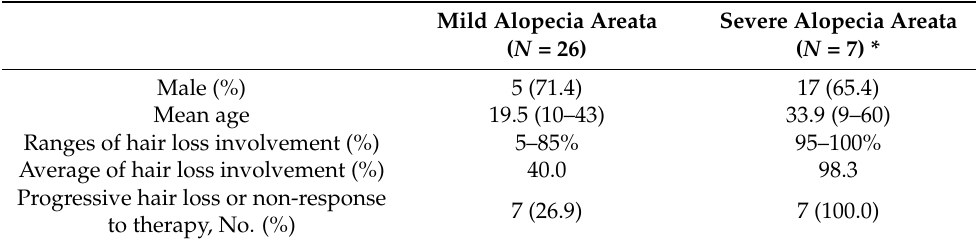
Table 1. Clinical parameters of study cohort involved in this